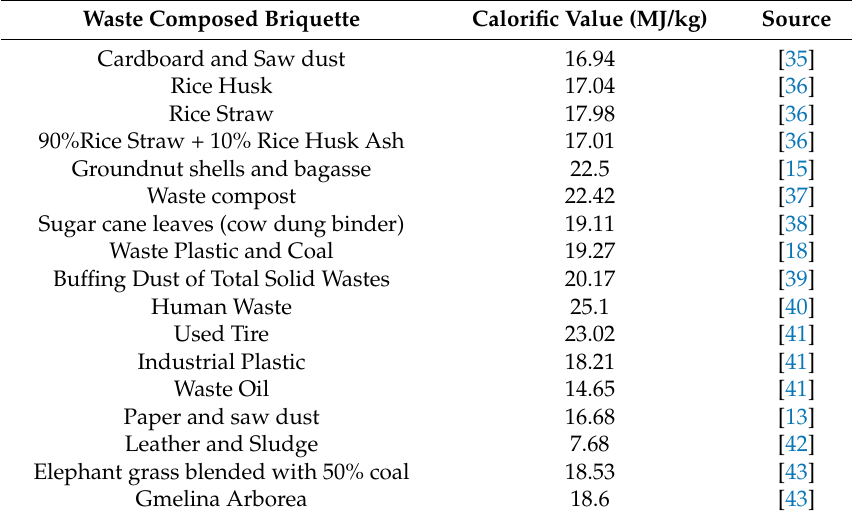
Table 6. Calorific values of other waste derived